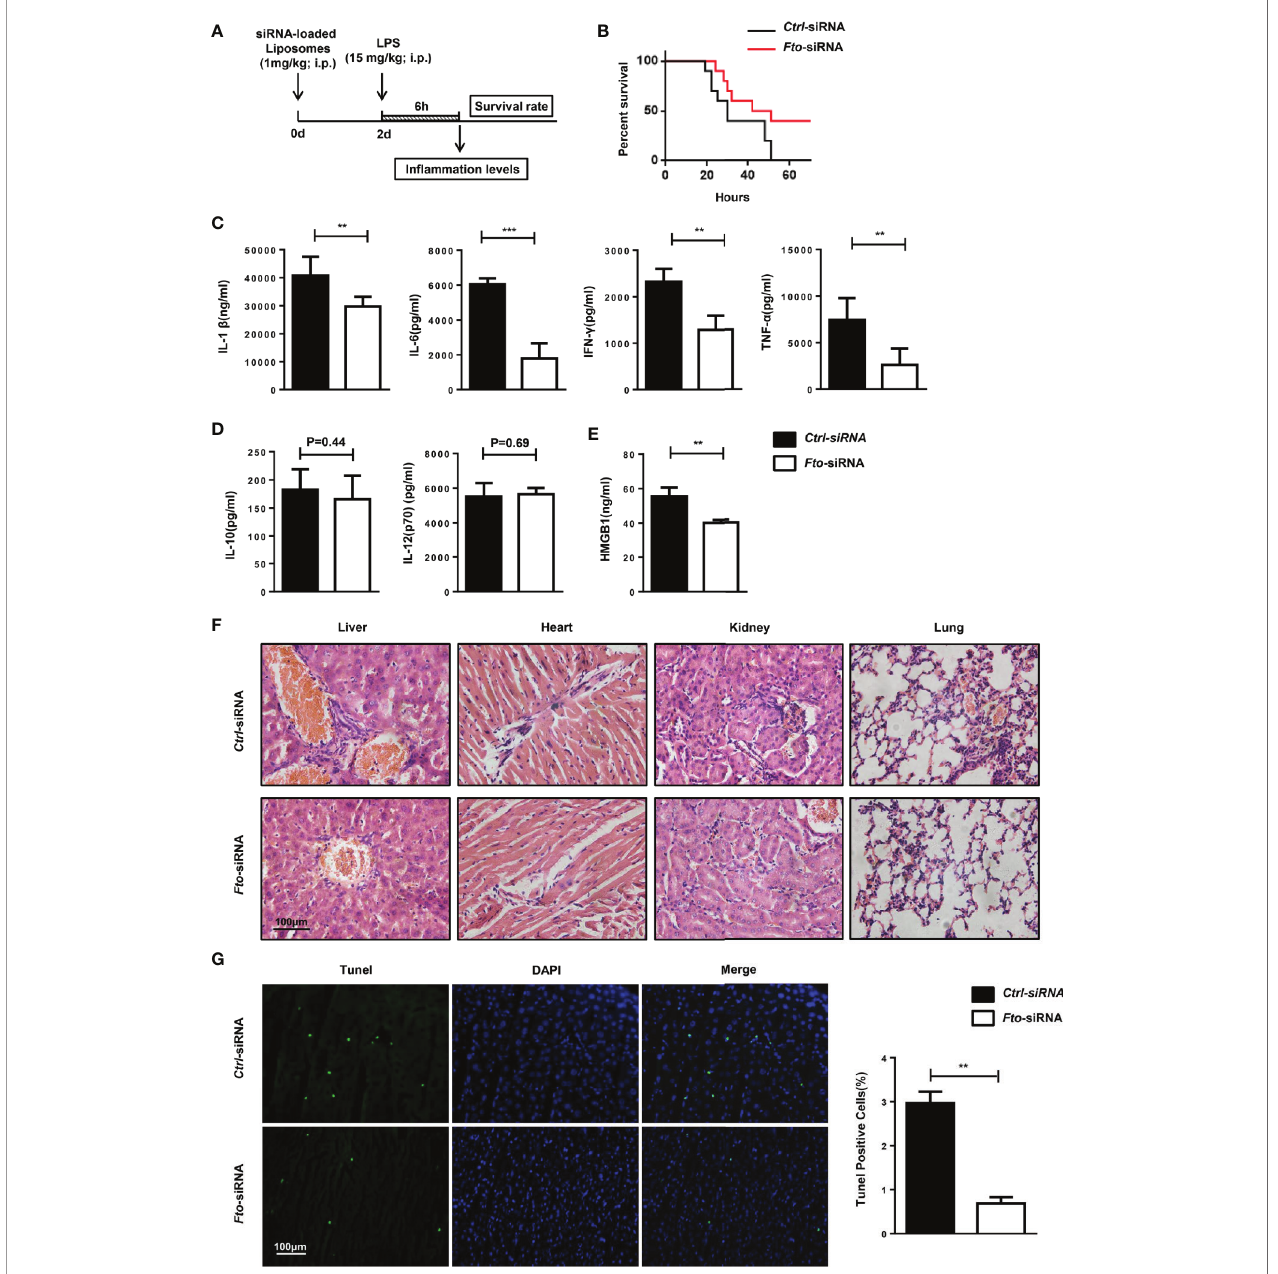
FIGURE 3 | Intraperitoneal administration of Fto siRNA liposomes protects mice against LPS-induced septic shock. (A) Nanoparticle-mediated Fto -siRNA or ctrl -siRNA were injected into C57BL/6 mice 2 days before LPS challenge. (B) Survival rate of mice injected with siRNA loaded-liposomes (n = 16). (C, D) Serum levels of IL-1 b , IL-6, TNF- a , IFN- g , IL-10 and IL-12(p10) were measured 6 h after LPS injection with pretreatment of Fto -siRNA or ctrl -siRNA liposomes. Plasma cytokine concentrations were measured by ELISA(n = 4 in each group). (E) Analysis of serum HMGB1 levels by ELISA. (F) Histology of representative tissues stained with hematoxylin and eosin (size bar, 50 m m). (G) The TUNEL assay of liver tissue sections. Data are shown as mean ± SEM; **P < 0.01; ***P < 0.001 (two-tailed unpaired